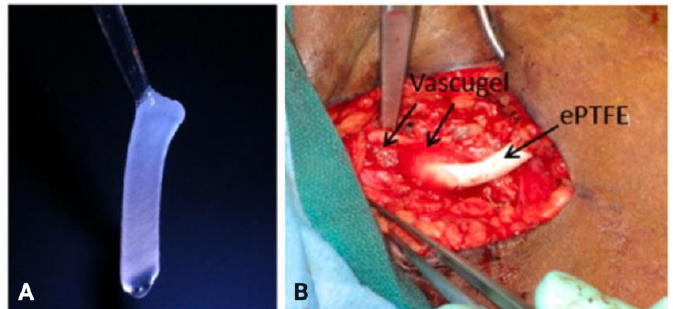
Figure 7. ( A ) Sample of a Vascugel sponge used in the trial. ( B ) Sponge placement at the anastomotic site of an AVG. Images are reprinted, with permission, from Conte et al. (2009)